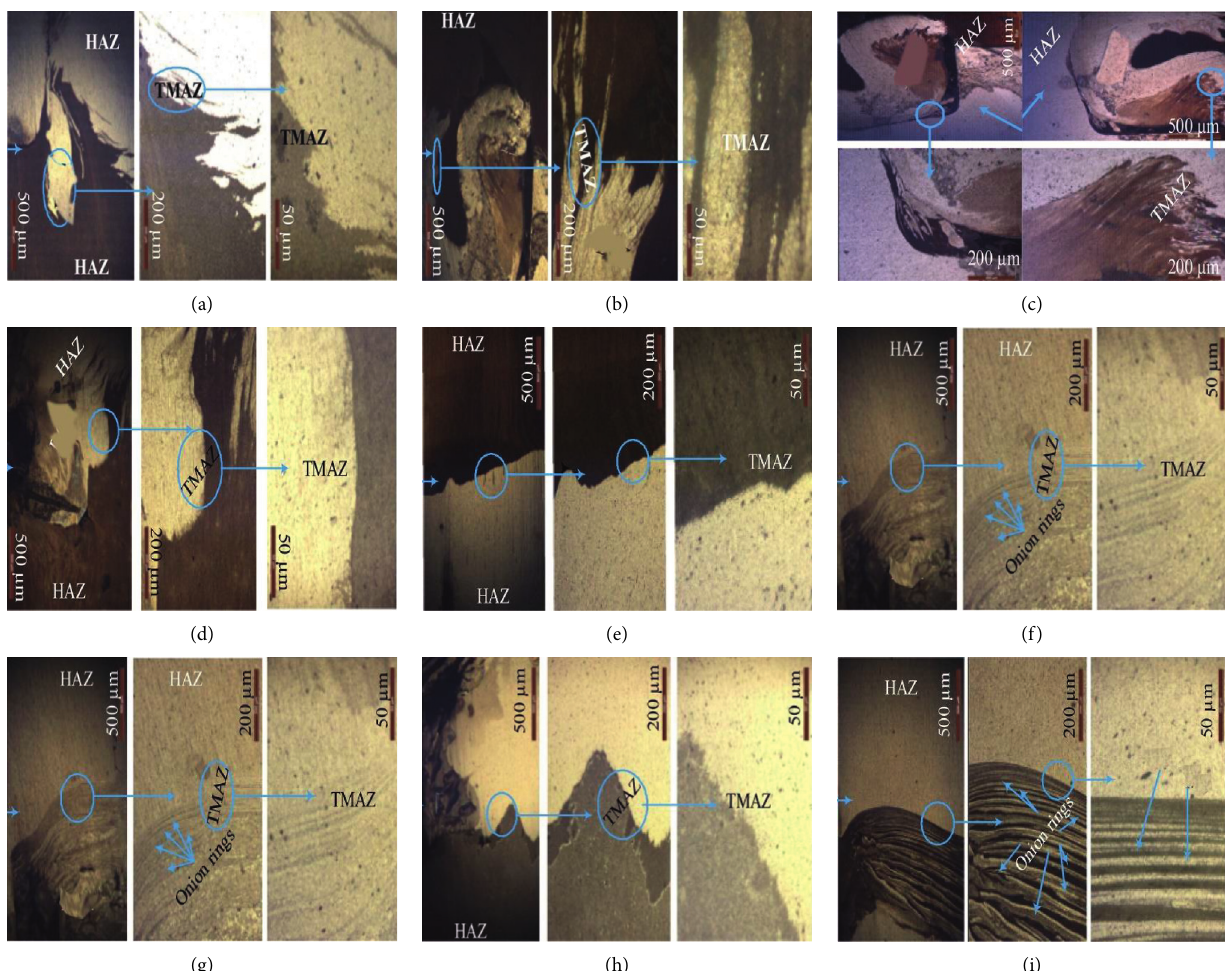
Figure 9: Obtained microstructural images with different welding parameters. (a) TRS: 500rpm, and feed rate: 30mm/min. (b) TRS: 500rpm, and feed rate: 40mm/min. (c) TRS: 500rpm, and feed rate: 50mm/min. (d) TRS: 1000rpm, and feed rate: 30 mm/min. (e) TRS: 1000rpm, and feed rate: 40mm/min. (f) TRS: 1000rpm, and feed rate: 50mm/min. (g) TRS: 1500rpm, and feed rate: 30mm/min. (h) TRS: 1500rpm, and feed rate: 40mm/min. (i) TRS: 1500rpm, and feed rate: 50mm/min.